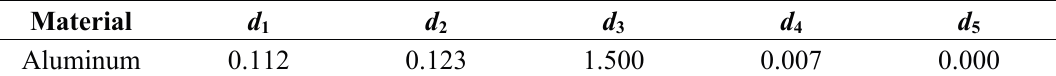
Table 5. Failure damage mode parameters of Al foil.